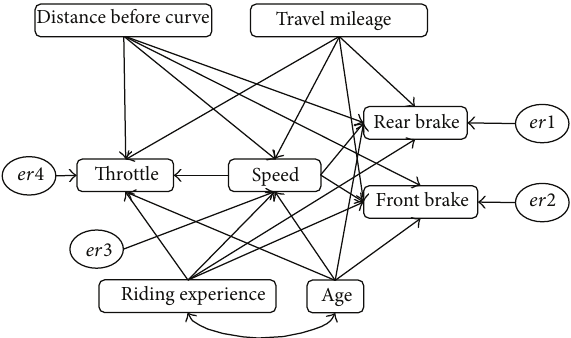
Figure 7: Path model for the prediction of riding behaviour before curve